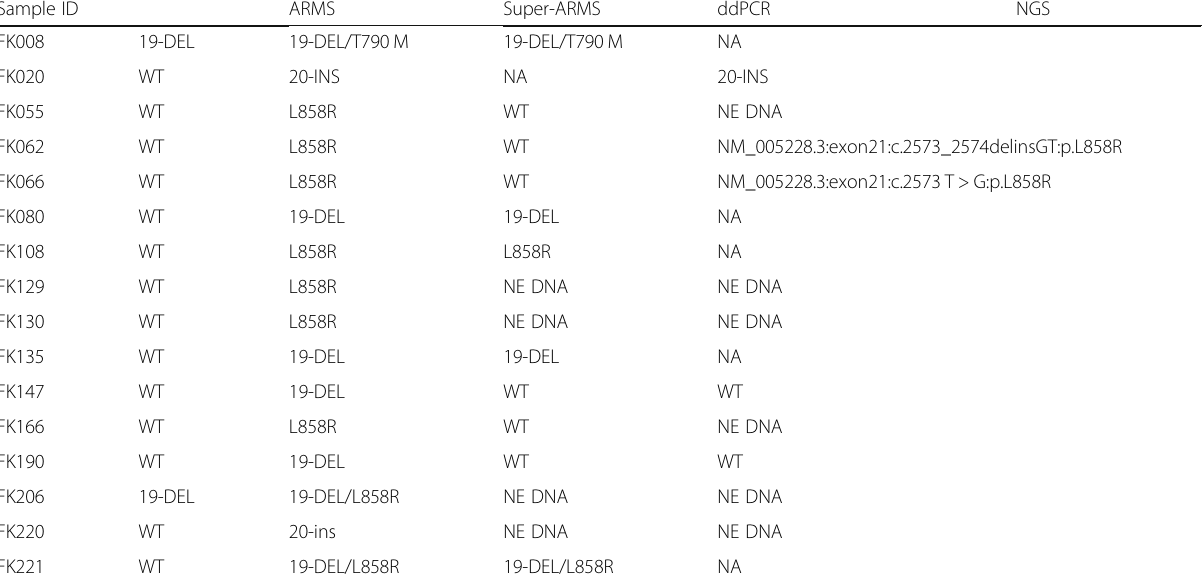
Table 3 Sixteen Nonconcordant Cases of SuperARMS and ARMS for Cytology EGFR Detection Sample ID